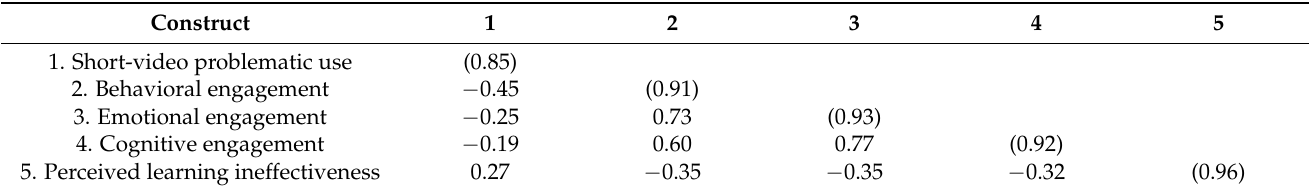
Table 3. Discriminant construct